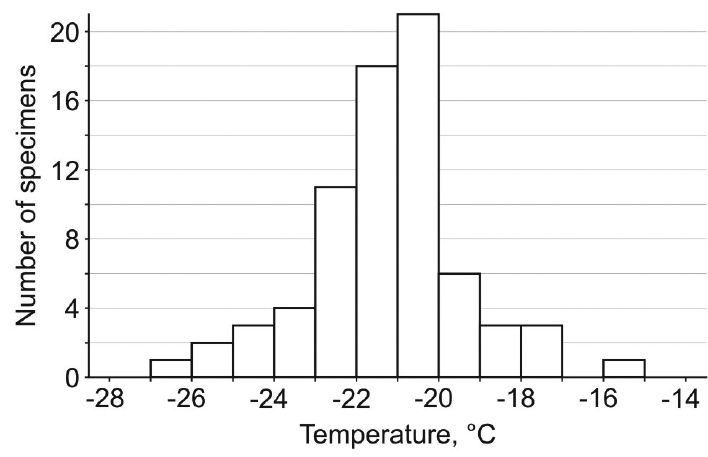
Figure 2. Histogram of Telenomus tetratomus SCP distribution